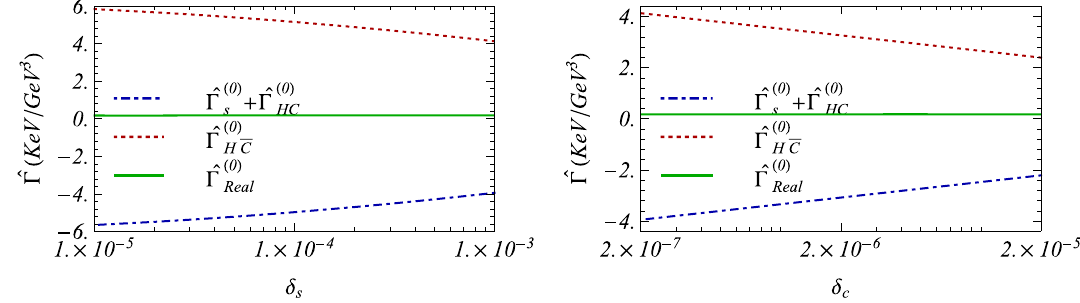
Fig. 3 The verification of the independence on the cutoff parameters δ s and δ c . The superscript “(0)” denotes the (cid:8) 0 -order terms. In the left diagram, δ = 2 × 10 − 7 . In the right diagram, δ c